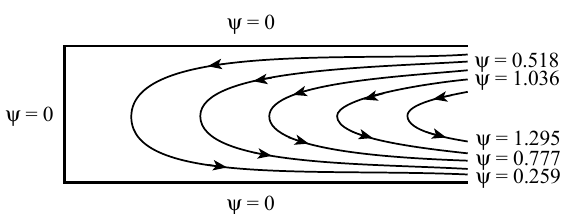
Figure 3. Graphical description of the resulting flow field; five streamlines equally spaced between their minimum value ψ min = 0 at the rigid boundaries and their maximum value ψ max = 1.554. The values in the figure correspond to every other streamline. (Reprinted from [37], with permission from Elsevier Science Ltd.)